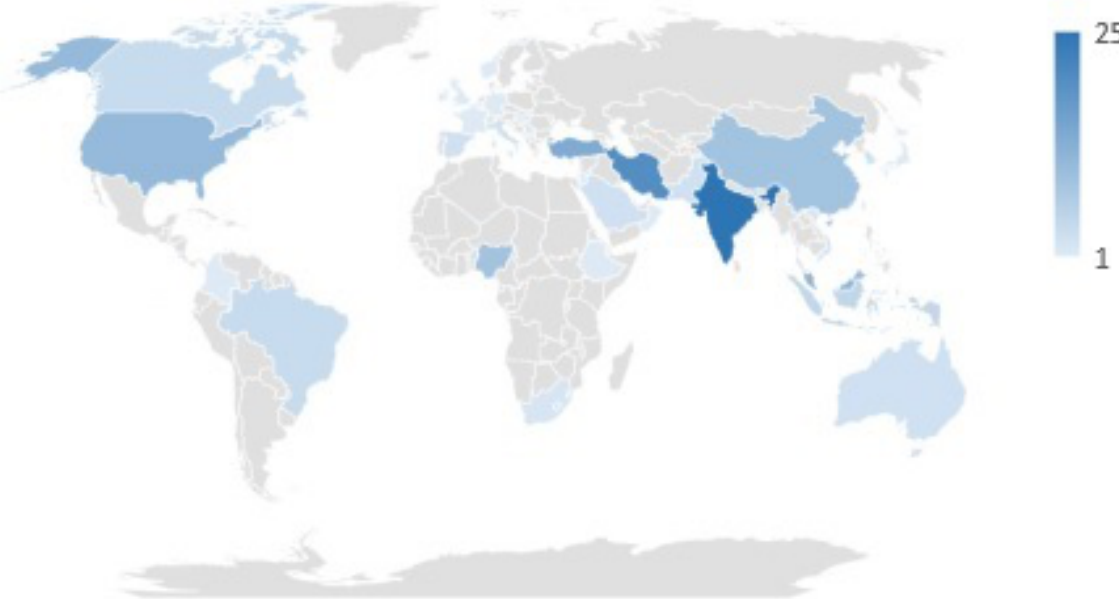
Figure 3. Region-wise publications on ML applications in biofuels’ life